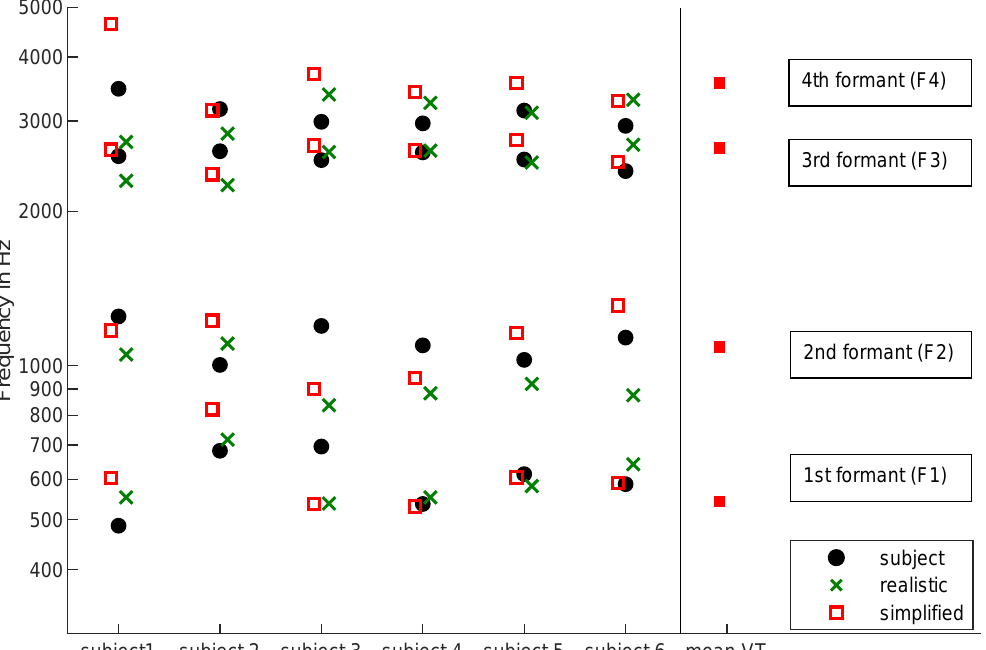
Figure 7. Formant frequencies of the realistic and the simplified VT replicas based on the MRI-data by Echternach et al. [34] originating from six tenors singing the vowel /a/. Additionally, the subjects’ formant frequencies are plotted as detected by Echternach et al. [34] from audio recordings. The applied detection method for all formants is based on inverse filtering, as described in Section 2.3.